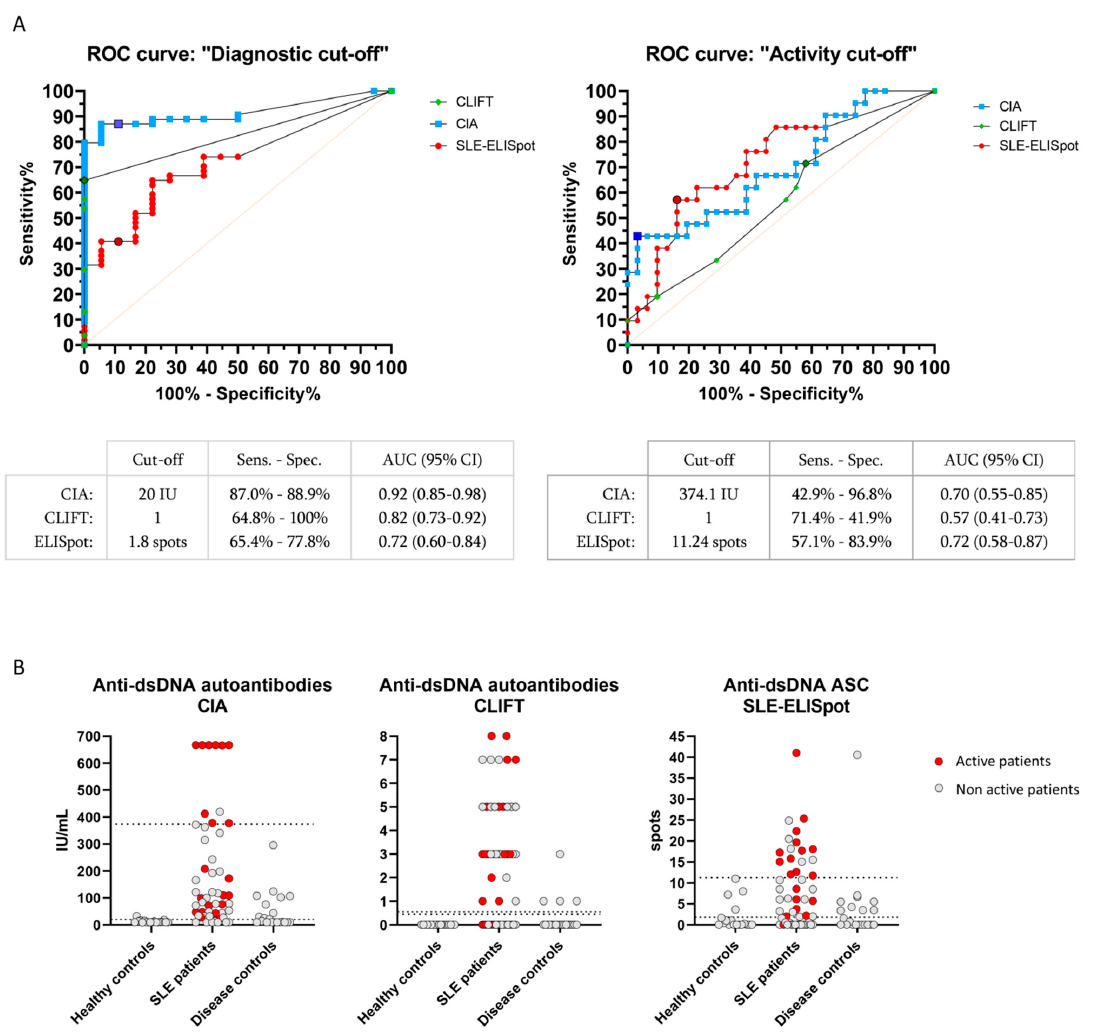
Figure 2. CIA, CLIFT and SLE-ELISpot results: ROC curves and values distribution. ROC curves analysis using diagnostic cut-off ( A , left) and activity cut-off ( A , right) for CIA, CLIFT and SLE- ELISpot. Bordered signs indicate selected cut-off points. Values distribution for CIA ( B , left), CLIFT ( B , middle) and SLE-ELISpot ( B , right). Dashed lines: diagnostic cut-off. Pointed lines: activity cut-off. Red signs indicate active SLE patients. Grey signs indicate non-active SLE patients. Abbreviations: AUC (Area under the curve); Sens (Sensitivity); Spec (Specificity).